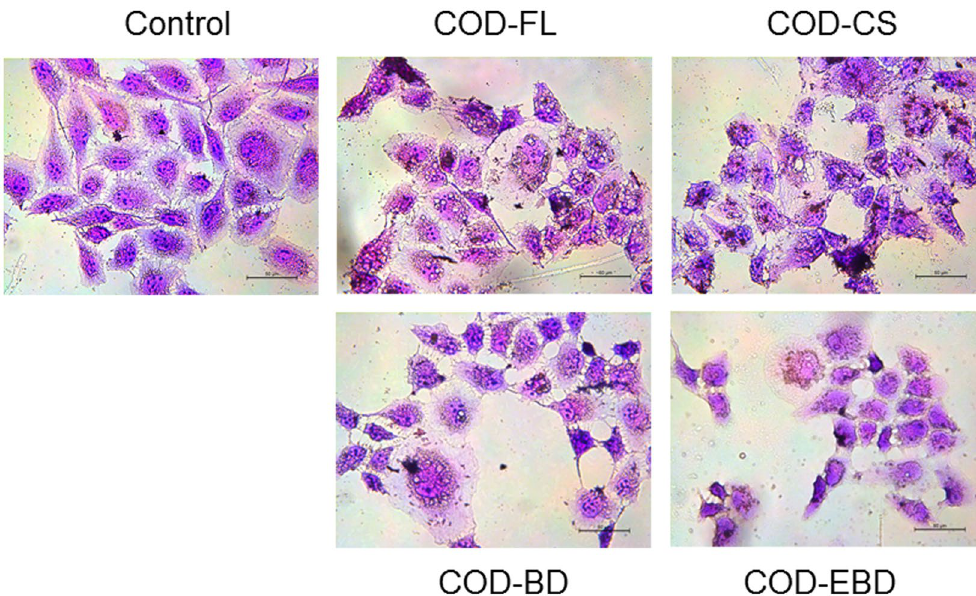
Figure 3. Morphology observation by HE staining of HK-2 cells after exposure to 400 μ g/mL COD crystals with various shapes for 6 hours. Scale bars: 50 μ